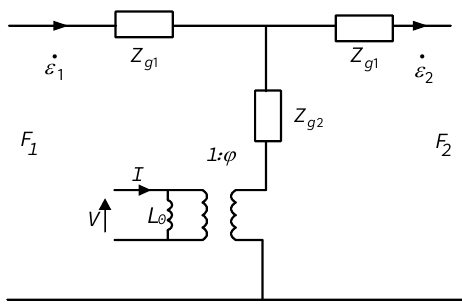
Figure 3. Configuration of a k 33 sample.